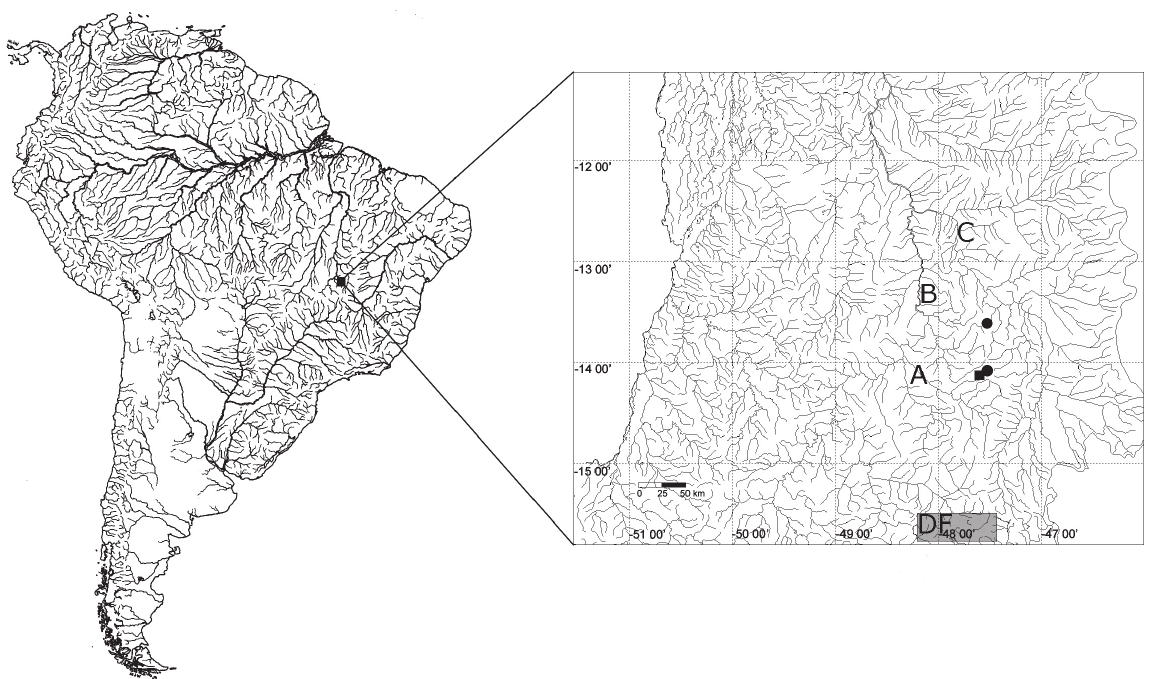
Fig. 3. Distribution of Astyanax goyanensis (circles) and A . courensis , new species (square), on upper rio Tocantins, Alto Paraíso de Goiás, Goiás State, Brazil. A, rio Tocantinzinho; B, rio Tocantins; C, rio Paranã; DF, Distrito Federal. Symbols can represent more than one lot or locality. Base map prepared by Marilyn